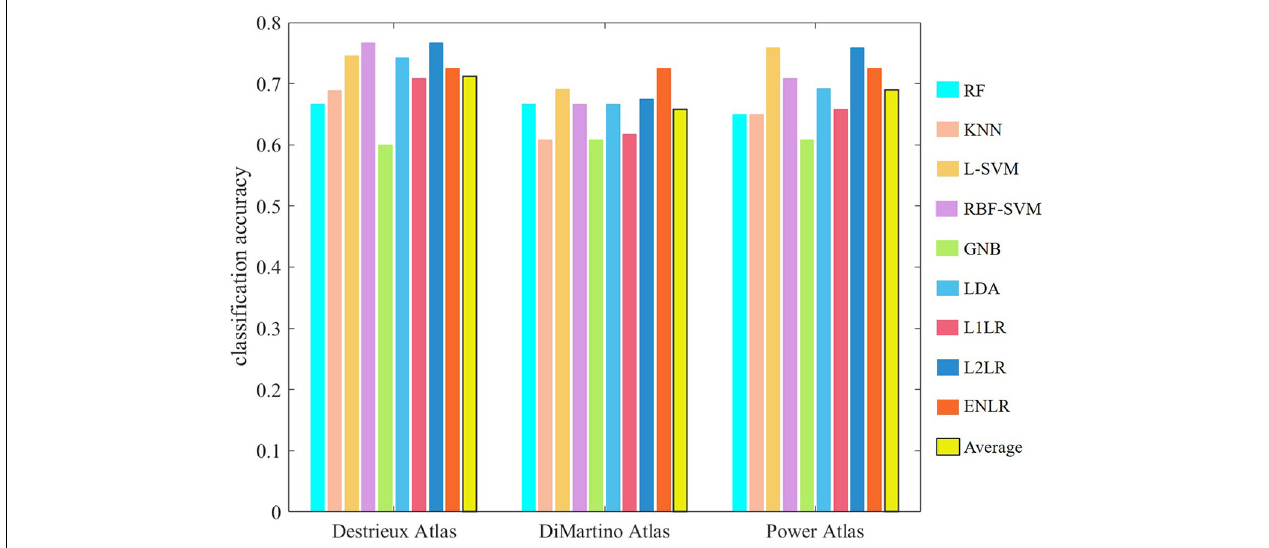
FIGURE 3 | Classification accuracy comparison based on different choice of atlas in the work of Plitt et al. (2015). RF, random forests; KNN, K-nearest neighbor; L-SVM, linear support vector machine; RBF-SVM, Gaussian kernel support vector machine; GNB, Gaussian naïve Bayes; LDA, linear discriminant analysis; L1LR, L1 logistic regression; L2LR, L2 logistic regression; ENLR, elastic-net logistic regression; Average, average of the above nine